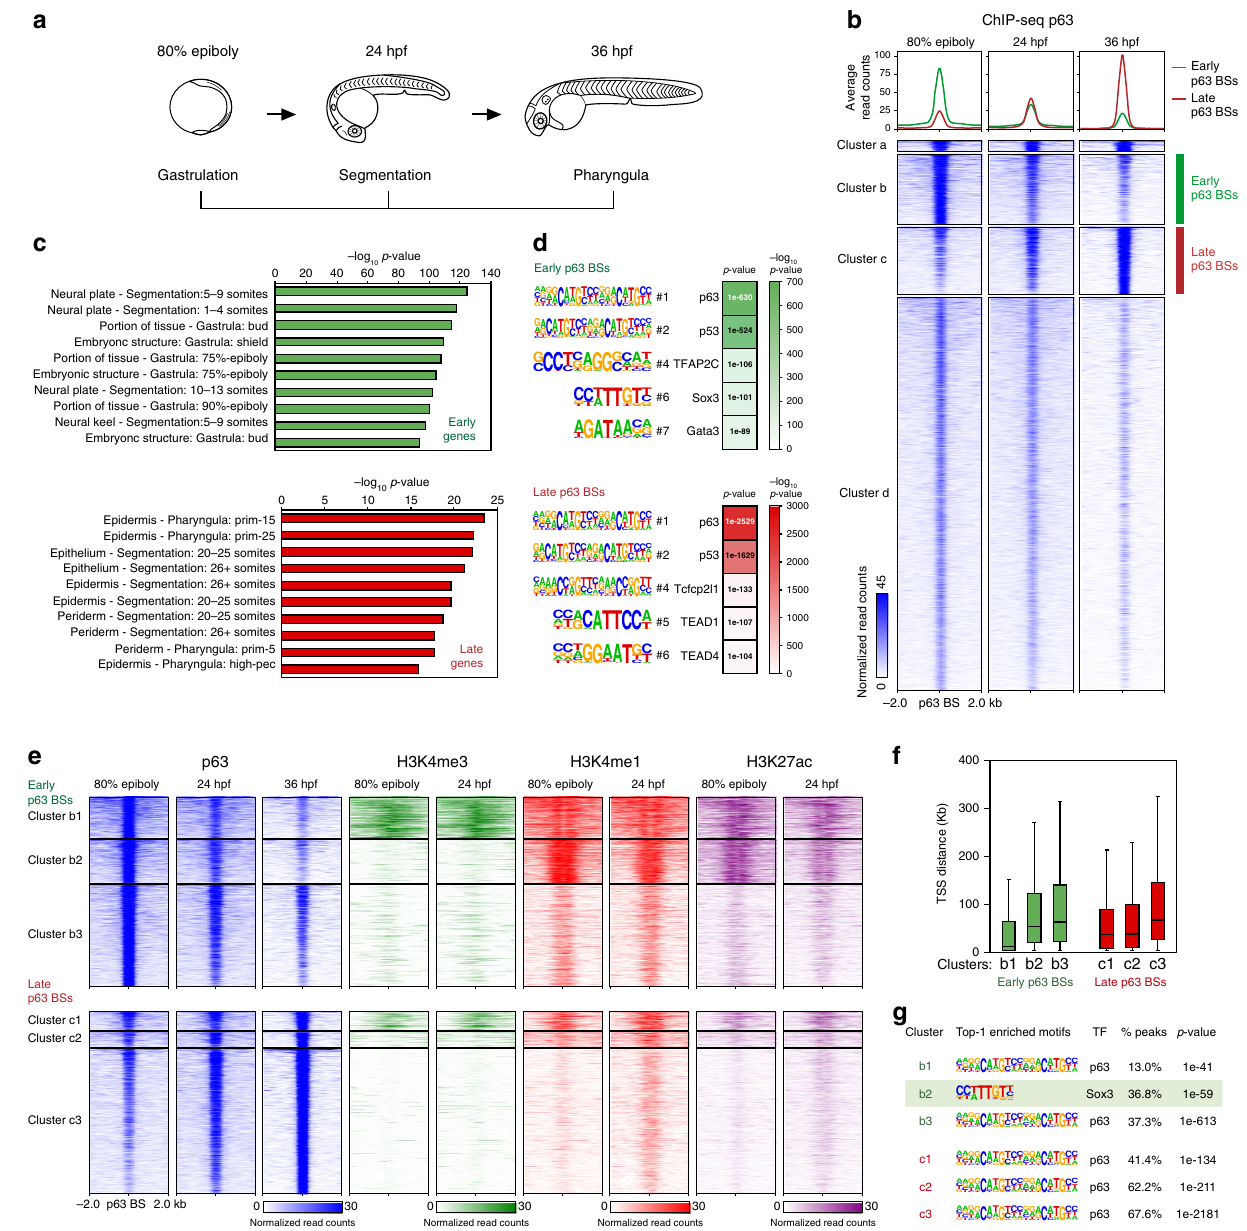
Fig. 2 Dynamics of p63 binding during development in zebra fi sh embryos. a Picture illustrating zebra fi sh developmental stages in which most experiments were performed. b Heatmaps of the 30,597 p63 binding sites (BSs) obtained from ChIPmentation in 80% of epiboly, 24 and 36 hpf stages ( n = 2 biological replicates per stage). Peaks were clustered using k -means clustering, obtaining four groups: cluster a ( n = 656), cluster b ( n = 3,956), cluster c ( n = 3,801) and cluster d ( n = 22,184). Average pro fi les of cluster b, which was used as the group of early p63 BSs, and cluster c, as late p63 BSs, are shown on top. c Top-10 enrichment of WT expression patterns of the genes corresponding to early (top) and late (bottom) p63 BSs. The -log 10 of p -value for each term is shown. d Motif enrichment analysis of the early (top) and late (bottom) p63 BSs. Five representative motifs of the top-10 were chosen. Motif logos are represented with their position in the top-10, the transcription factor (TF) name and the enrichment p -value in a color scale. e Heatmaps of the early (top) and late (bottom) p63 BSs clustered according to chromatin marks H3K4me3, H3K4me1 and H3K27ac in 80% of epiboly and 24 hpf. Peaks were clustered using k -means clustering, obtaining three sub-clusters per each group: b1 ( n = 875), b2 ( n = 912), b3 ( n = 2,169), c1 ( n = 396), c2 ( n = 330) and c3 ( n = 3,075). f Box plots showing the distance of the peak sub-clusters from ( e ) to the transcription start sites (TSS) of the nearby genes. Center line, median; box limits, upper and lower quartiles; whiskers, 1.5× interquartile range. Source data are provided as a Source Data fi le. g Motif enrichment analyses of the peak sub-clusters from ( e ) representing the most enriched motif in each one, their motif logos, percentage of peaks containing the motif and associated enrichment p -value. See also Supplementary Fig.